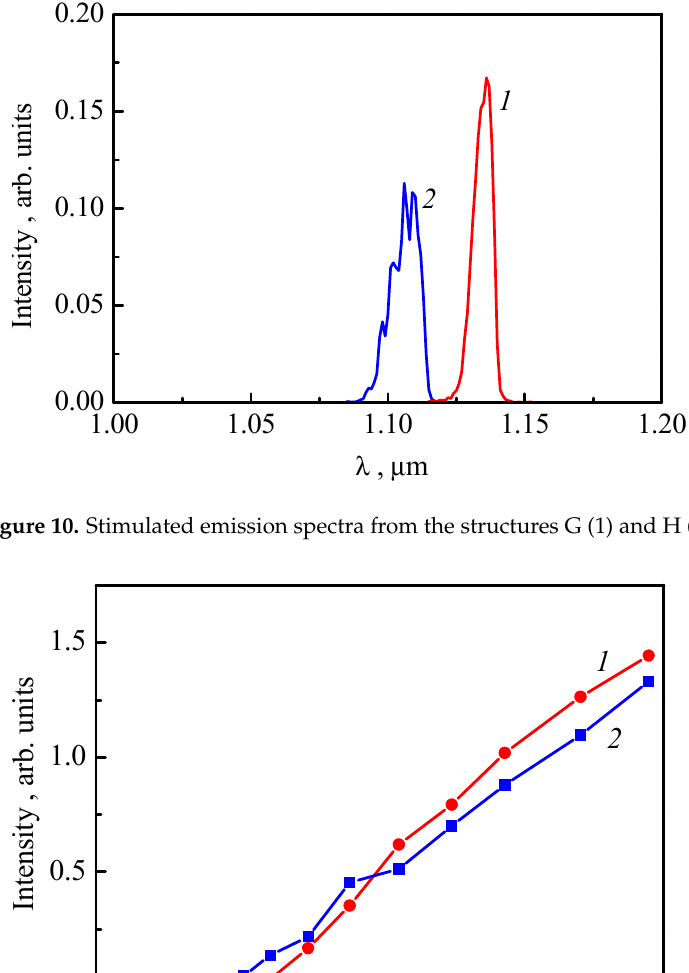
Figure 9. TEM images of the cross section of the laser heterostructure H: ( a ) Heterointerface with AlAs/GaAs/AlAs layers, ( b ) active region with InGaAs/GaAs QWs, ( c ) cross section of the entire heterostructure. The white arrows indicate defects.